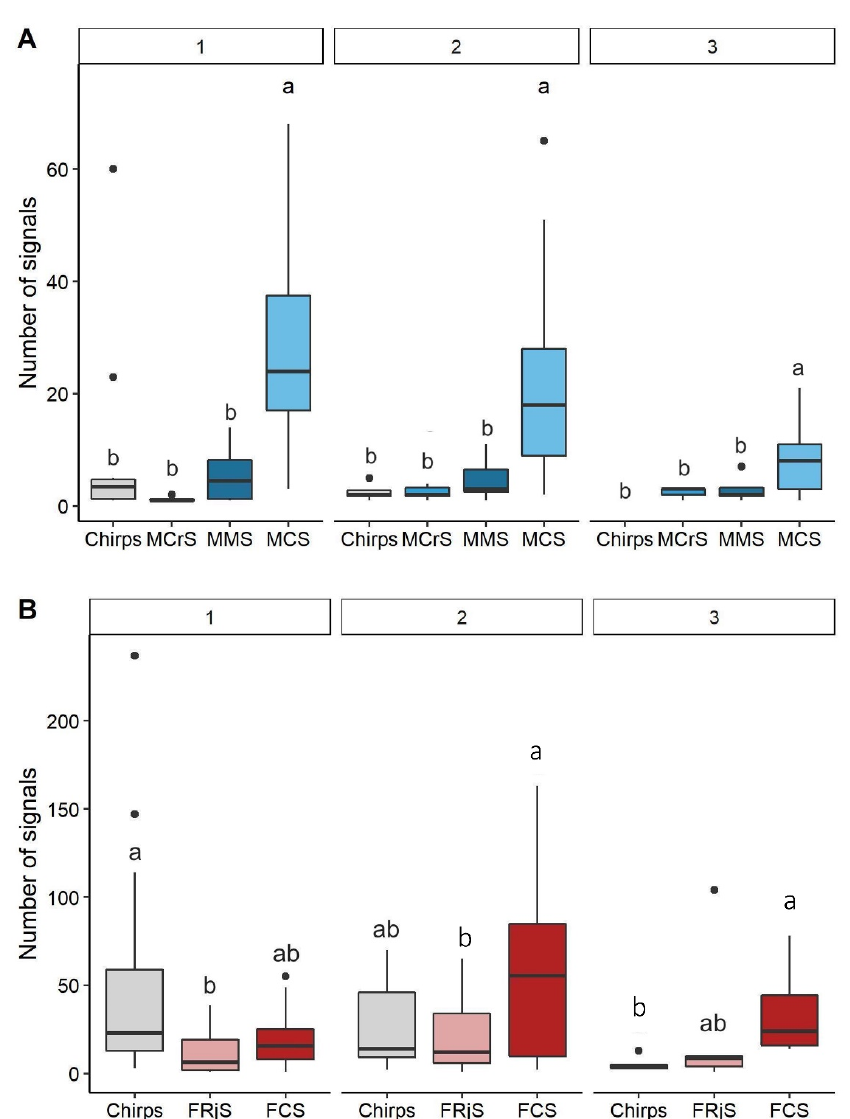
Figure 3. Number of signals emitted by males ( A ) and females ( B ) according to the type of signals and the number of signaling individuals (1, 2 and 3). Different letters (a, b) indicate significant pairwise differences ( p -value < 0.05) between types of signals for each number of signaling individuals. Black spots indicate